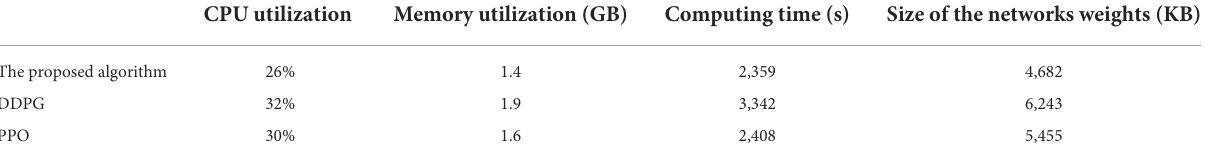
TABLE 5 Computing resources usage